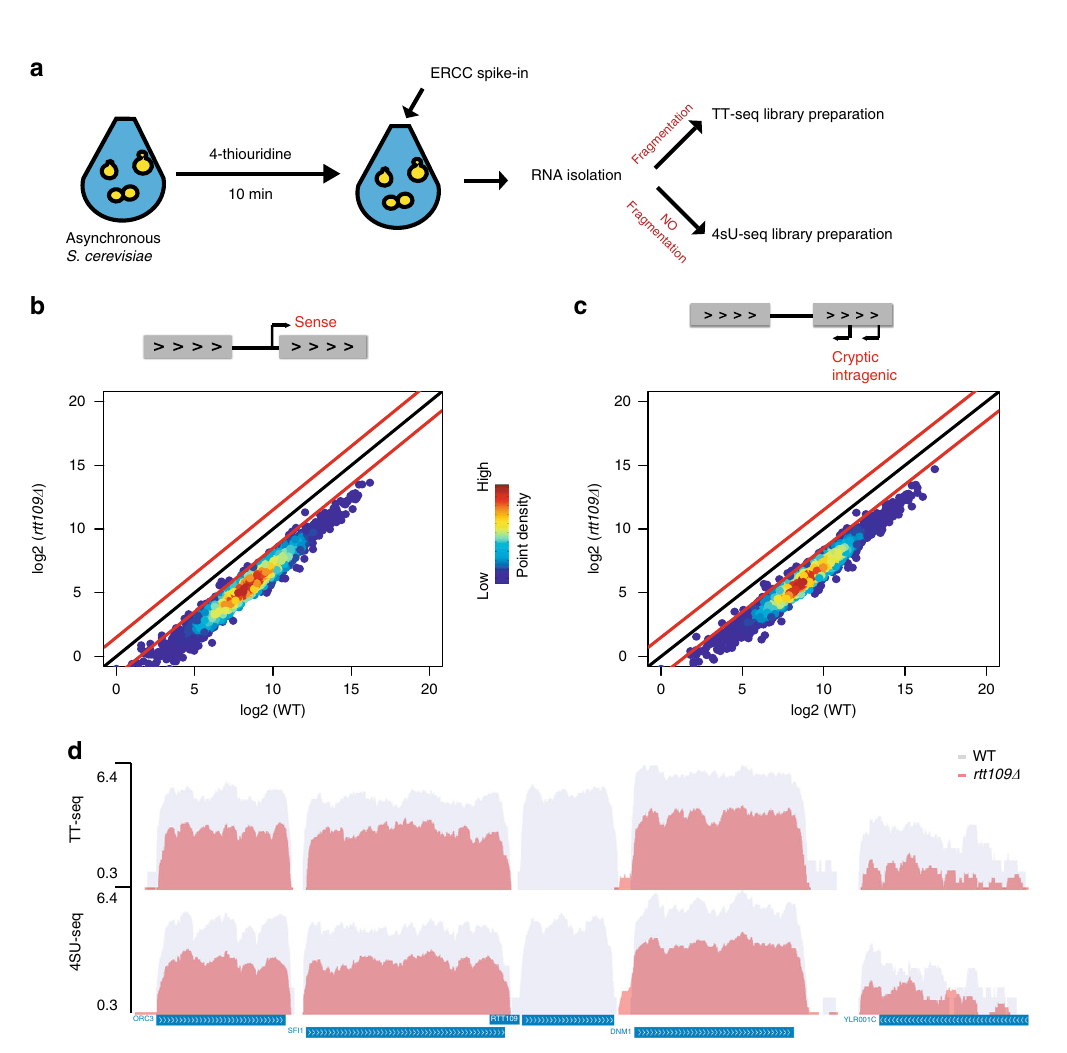
Fig. 3 H3-K56Ac promotes transcription initiation. a Experimental design for TT-Seq and 4sU-Seq. Asynchronous WT and rtt109 Δ cells were labeled with 2.5 mM 4tU for 10 min. Following fragmentation (TT-Seq libraries) or no fragmentation (4sU-Seq libraries), 4sU-labeled RNAs were isolated and sequenced. b Scatterplots showing coding nascent transcript levels, and c cryptic intragenic transcript levels between wild type and rtt109 Δ by TT-Seq. All reads are normalized according to ERCC spike-in numbers. d Selected genome browser view comparing wild-type (gray) and rtt109 Δ (red) for TT-Seq